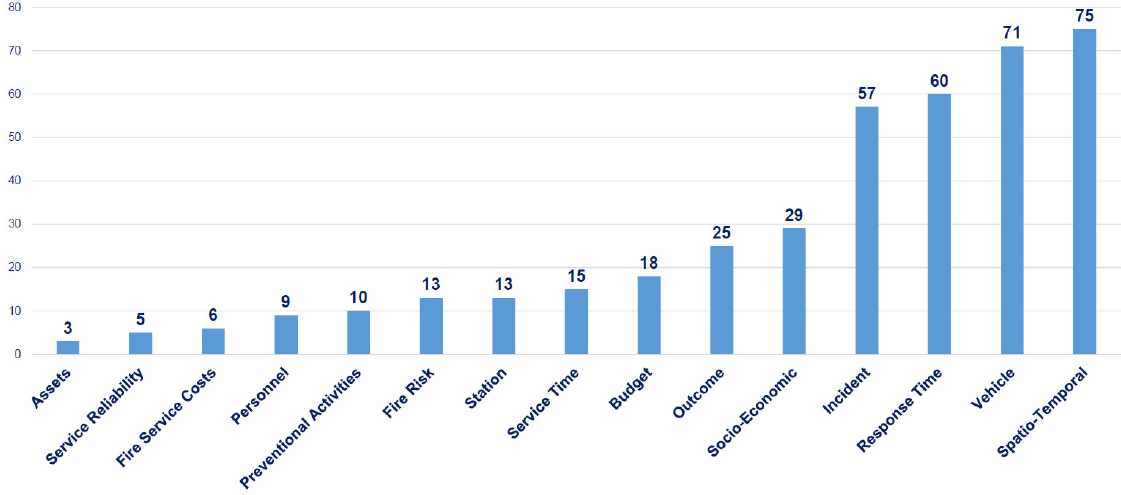
Figure 3. The frequency of the independent variables in the assessed FDPA papers.